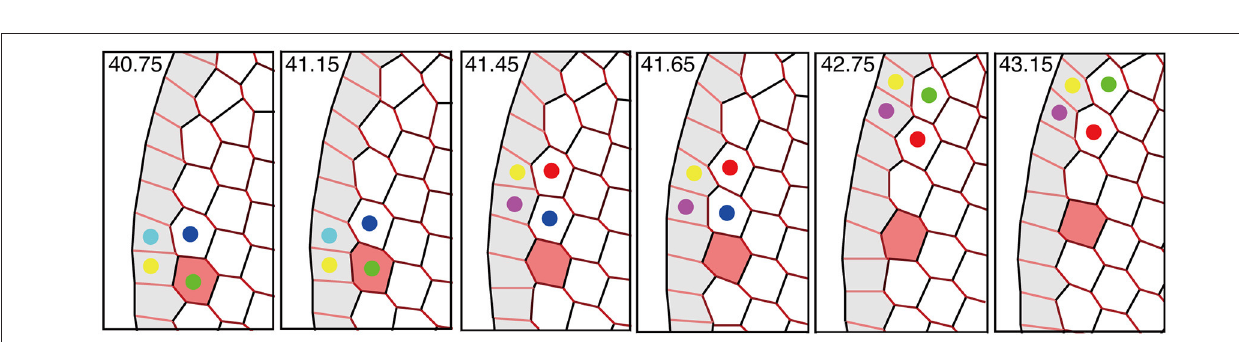
FIGURE 11 | Propagation of T1 transition and cell rearrangements. T1 transition occurs between cells (indicated by colored dots) that undergo cell intercalation. The propagation of T1 transition is much faster than the cell movement (see red-colored cell). This figure was obtained from our numerical simulation in the absence of tension fluctuations ( Kp =